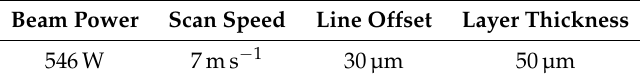
Table 1. Selective electron beam melting (SEBM) processing parameters for single crystalline base